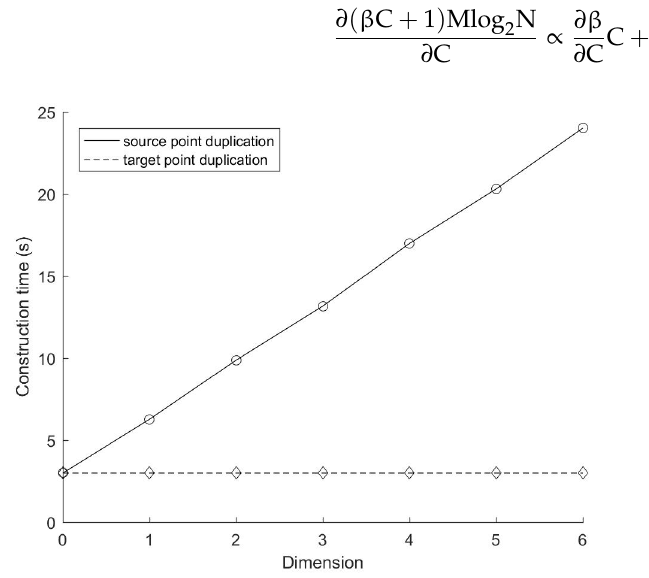
Figure 10. Construction time with different number of cyclic dimensions.